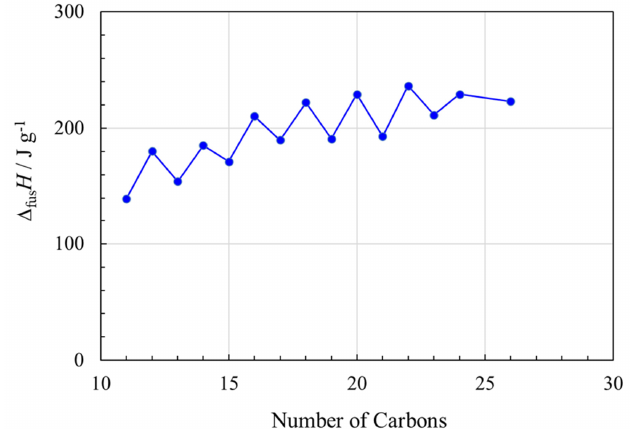
Figure 7. Enthalpy changes ( Δ H in J g − 1 ) associated with fusion (melting) of linear saturated fatty acids, as a function of number of carbons in the chain, n . See Supplementary Information for data and data